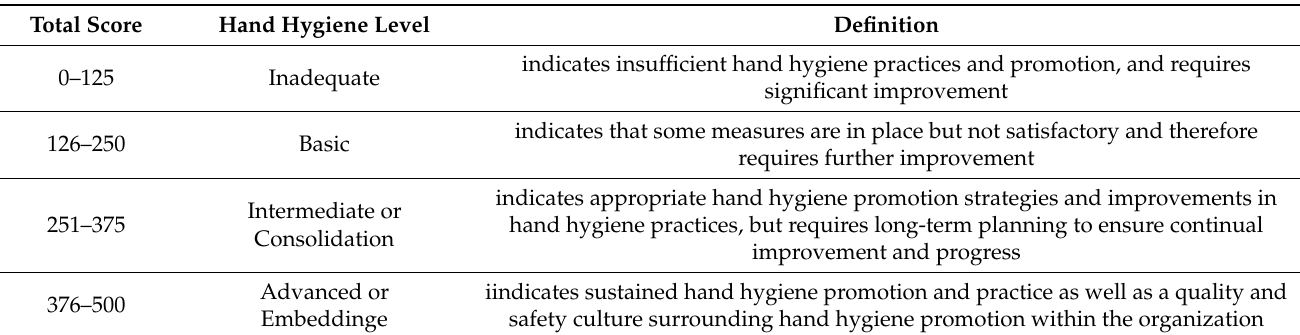
Table 1. Hand hygiene levels as assessed by scores from the questions in the WHO hand hygiene self-assessment framework.